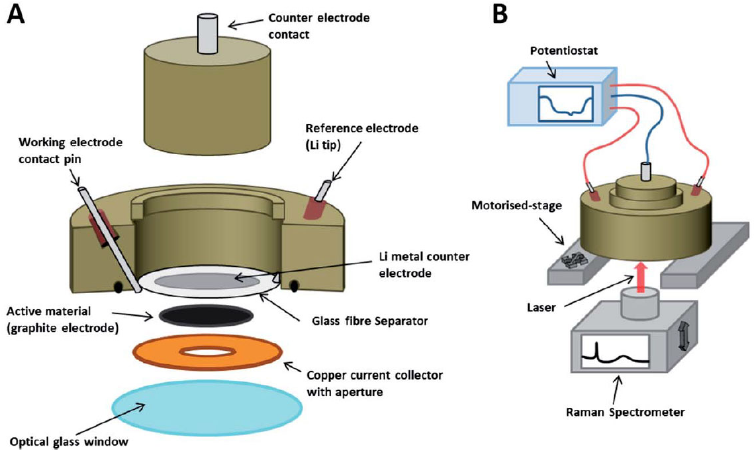
Figure 2. Schematic of ( A ) the Raman setup, and ( B ) the setup during cycling. Reprinted with permission from ref. [32]. Copyright 2014 The Royal Society of Chemistry, Faraday